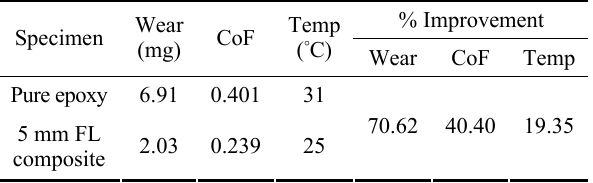
Table 10 Comparison of results at test condition: load 15 N and sliding distance 1,000 m.